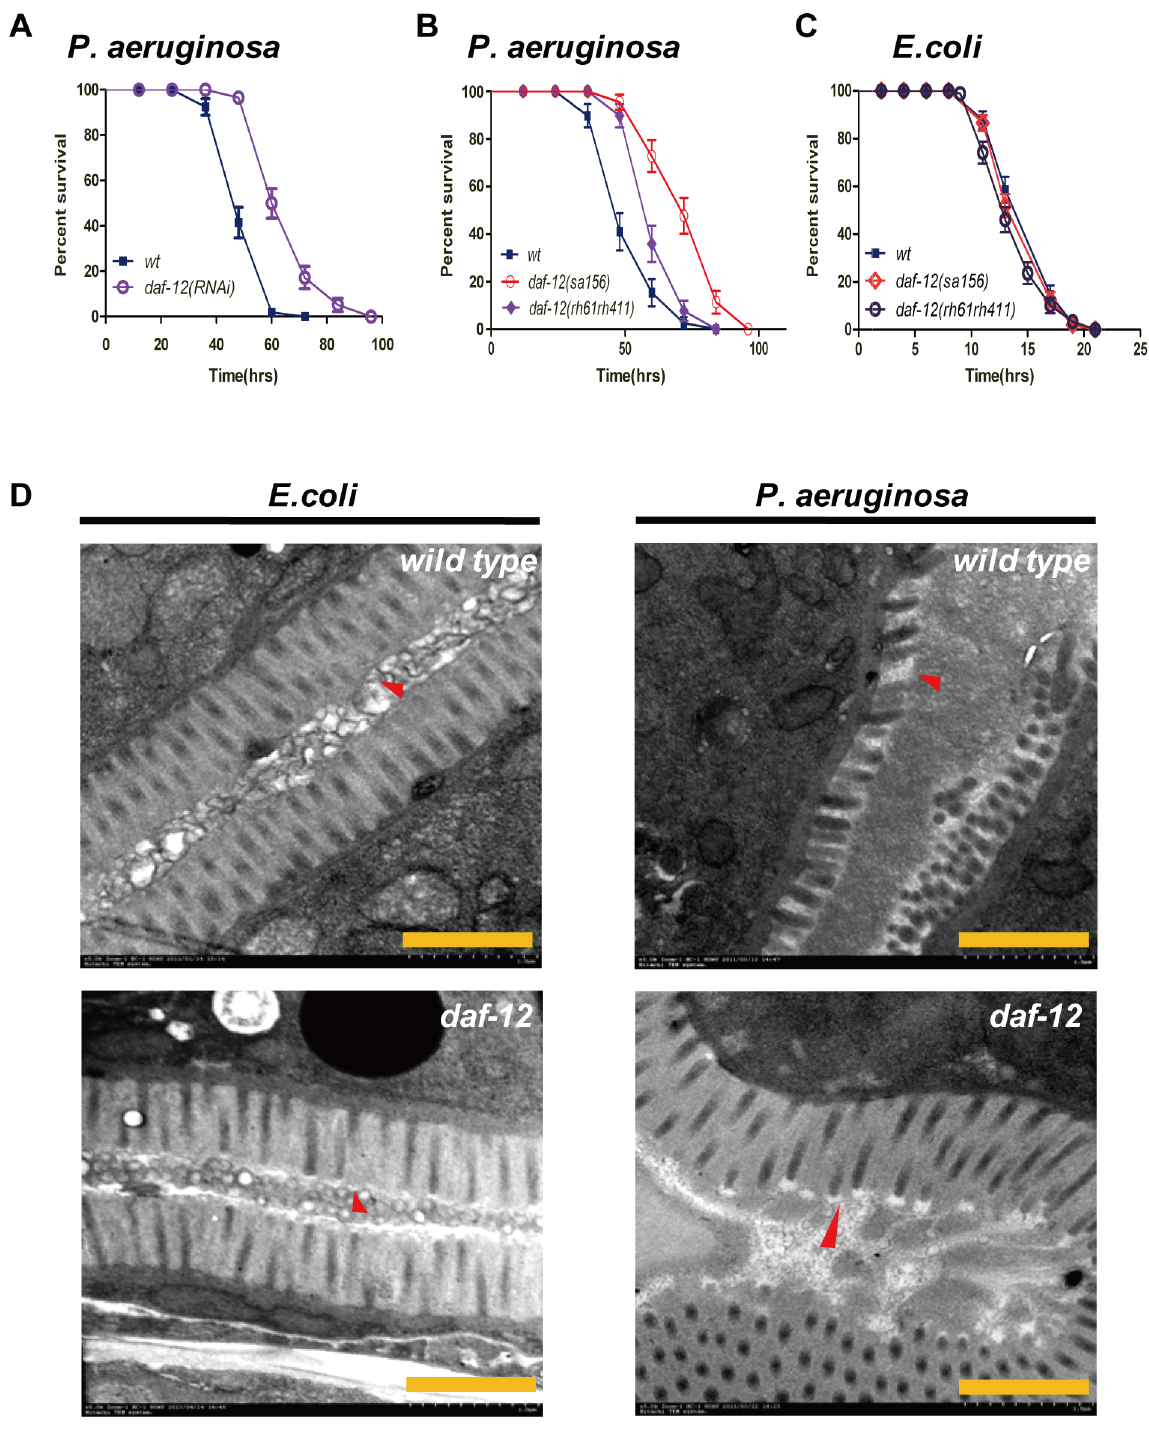
Figure 1. DAF-12 regulates pathogenic defense. ( A ) Survival curve of daf-12 RNAi-treated worms exposed to P. aeruginosa (PA) relative to control RNAi-treated worms ( P , 0.0001). ( B ) P. aeruginosa killing assay of wild-type N2, daf-12 ( sa156 ) ( P , 0.001) and daf-12 ( rh61rh411 ) ( P , 0.001) worms. ( C ) Lifespan curve of N2, daf-12 ( sa156 ) ( P =0.4118) and daf-12 ( rh61rh411 ) ( P =0.0019) worms. ( D ) Transmission electron micrographs (TEM) of a gut section from wild-type N2 and daf-12(sa156) worms fed E. coli or P. aeruginosa for 48 hours. Red arrows indicate microvillis. (Scale bars 1000 nm) All data shown above are representative of at least three independent experiments (n $ 50 adult nematodes per strain).